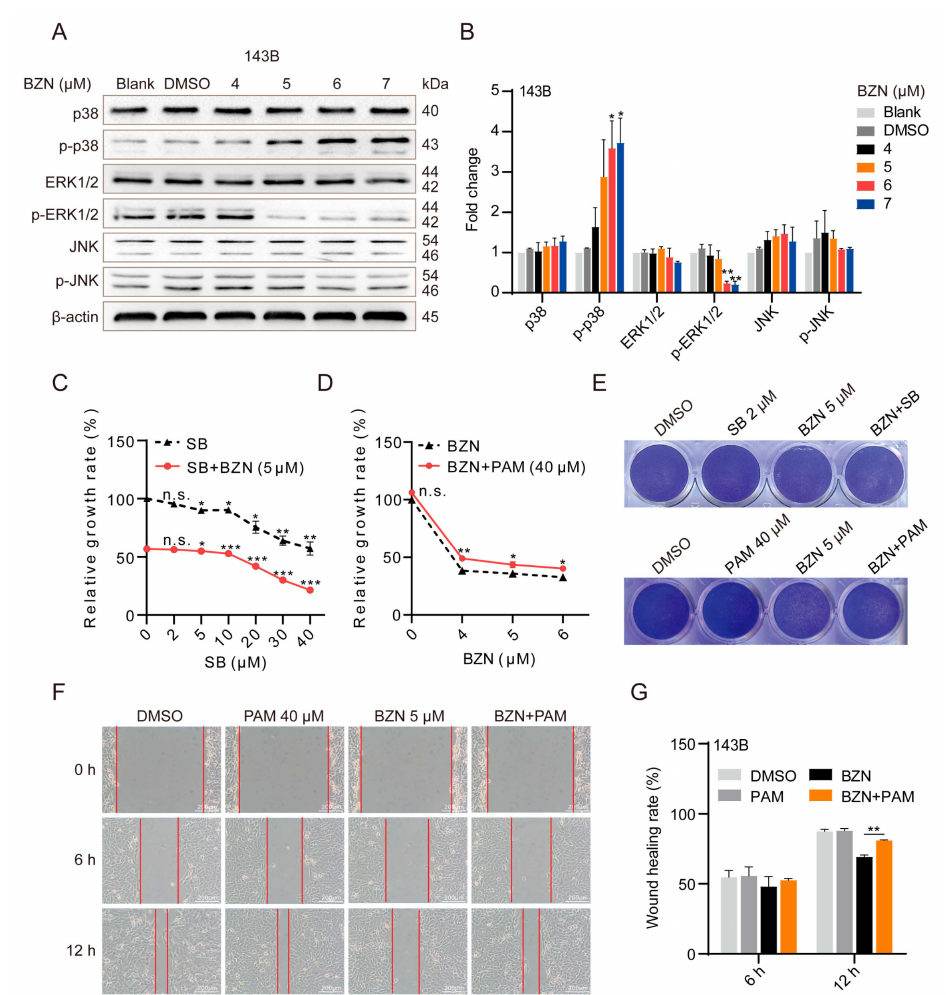
Figure 4. BZN-induced OS cell death involves the ERK1/2 signaling pathway. ( A ) The effect of BZN on p38, JNK, and ERK signaling pathways in 143B cells (Western blot). ( B ) Relative quantitative analysis of Western blot. ( C ) The effect of SB239063 in the presence or absence of BZN on the proliferation of 143B cells (MTT). * p < 0.05, ** p < 0.01, and *** p < 0.001 vs. SB = 0 µ M (black line: DMSO group, red line: BZN group). n.s., not significant. ( D ) The effect of BZN in the presence or absence of PAM on the proliferation of 143B cells (MTT). * p < 0.05 and ** p < 0.01 vs. BZN group. n.s., not significant. ( E ) The effect of SB239063 or PAM in combination with BZN on the proliferation of 143B cells (crystal violet staining). ( F ) The effect of PAM combined with BZN on the migration of 143B cells (wound healing assay, scale bars: 200 µ m). ( G ) Quantitative analysis of wound healing rate. Data are shown as mean ± SD from three independent experiments. ** p < 0.01 vs. BZN